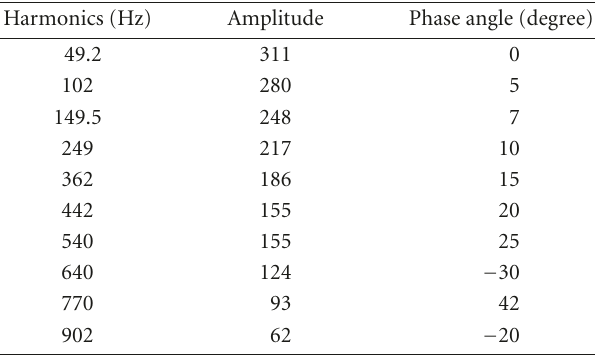
Table 1: Harmonics in the simulated signal.